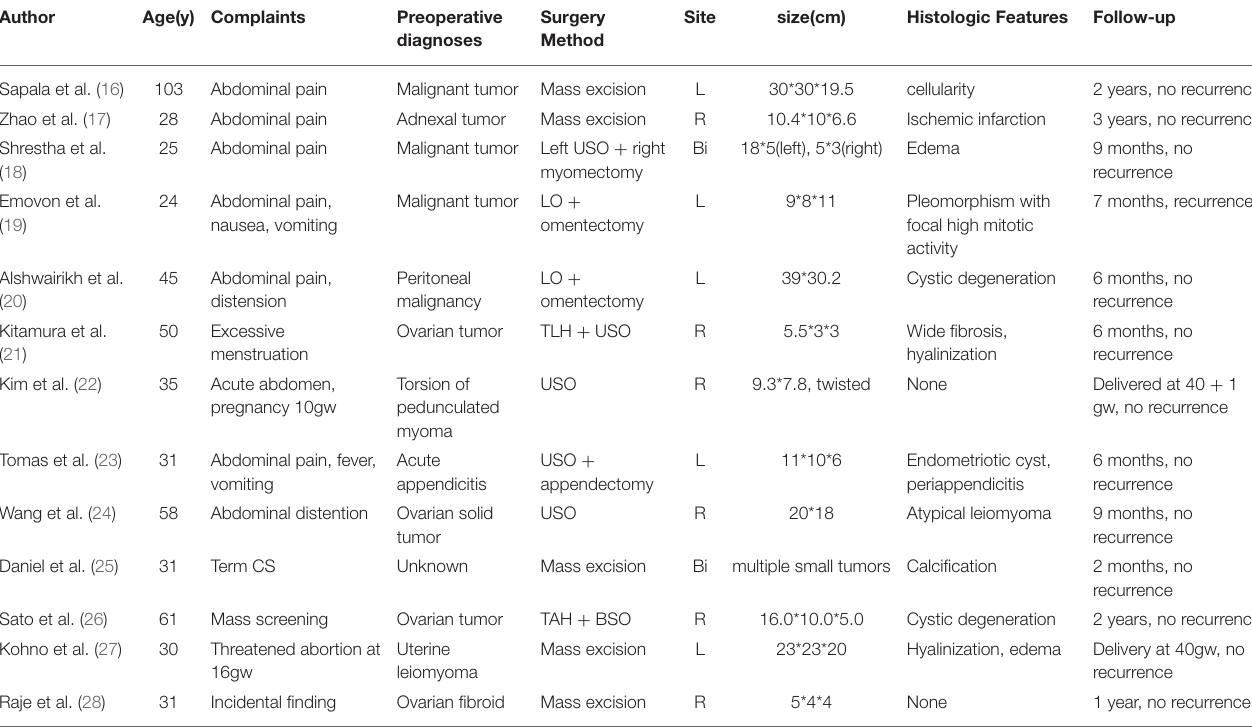
TABLE 8 | Characteristics of ovarian leiomyoma with detailed follow-up